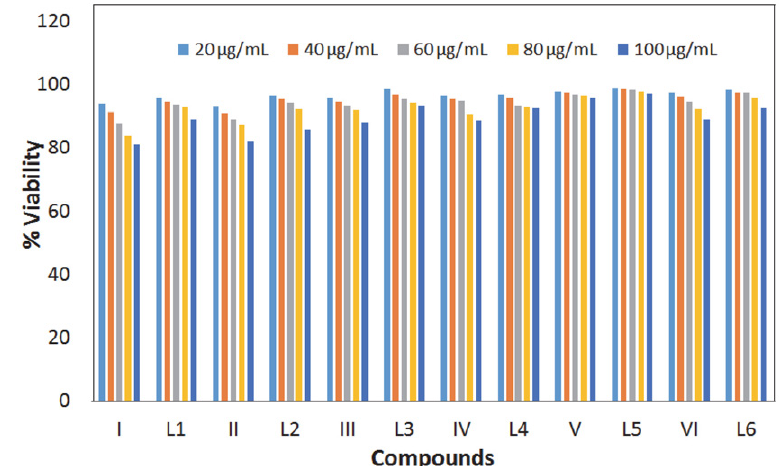
Figure 4. Effect of compounds on S. cerevisiae cells as increasing